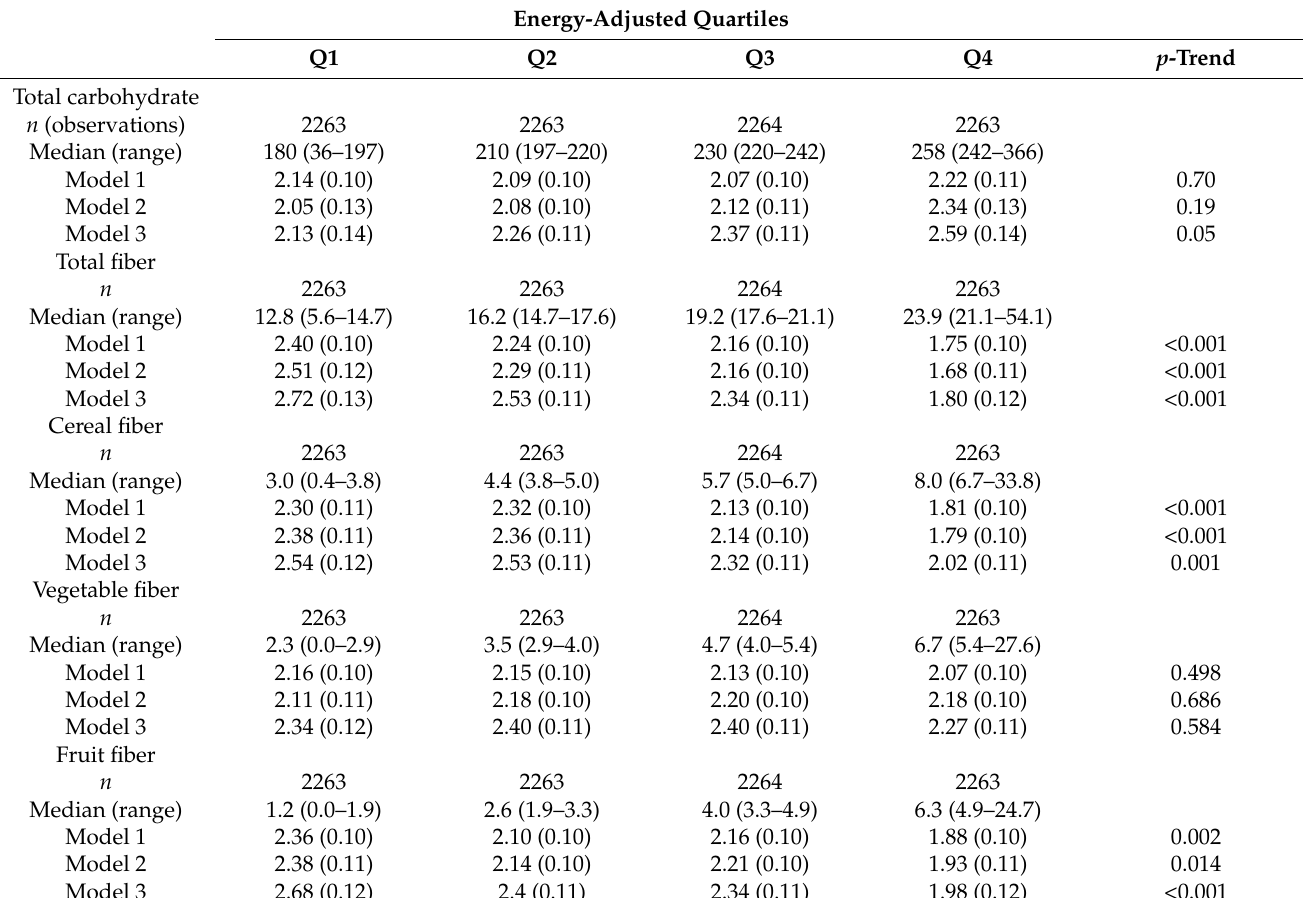
Table 6. Means (SE) of four-year change in waist circumference (cm) by quartiles of total carbohydrate, dietary fiber, and different food sources of fiber in 3101 participants of the Framingham Cohort